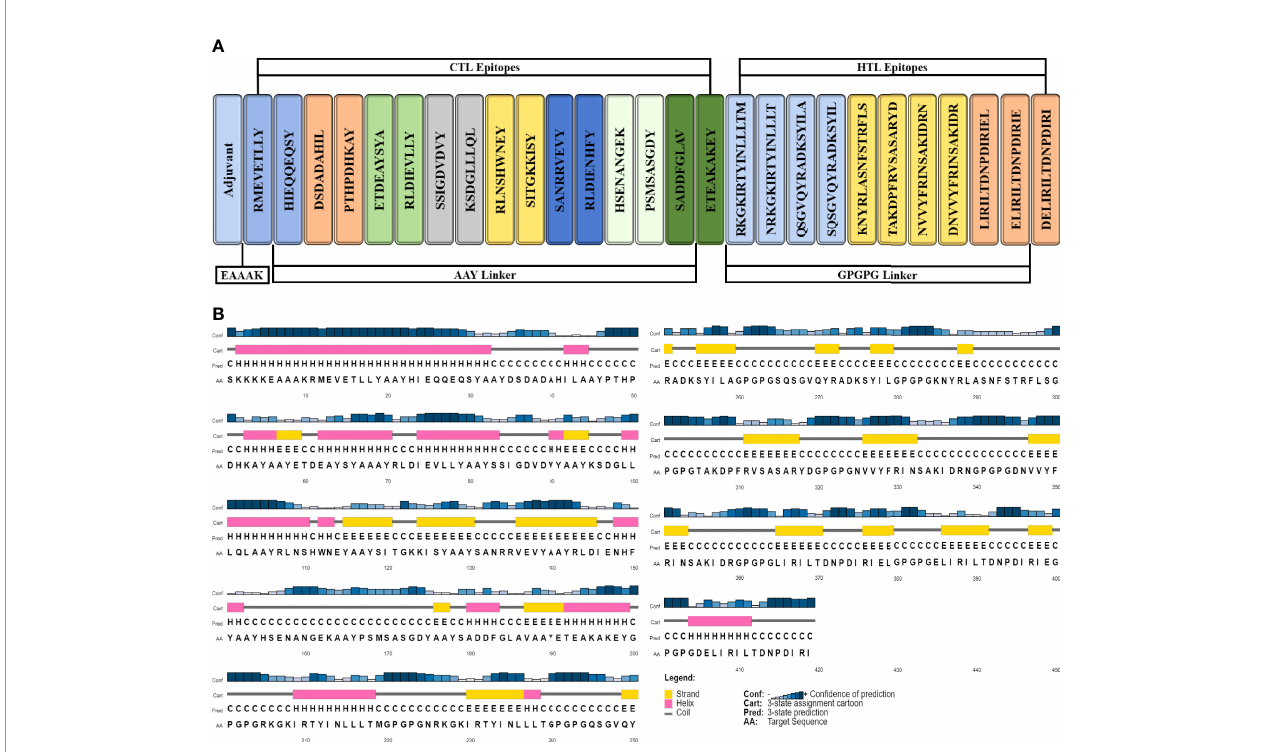
FIGURE 3 | Schematic illustration of 419-amino-acid-long vaccine construct sequence. (A) Representation of adjuvant and epitope arrangement in vaccine construct and (B) 2D structure prediction of vaccine construct.